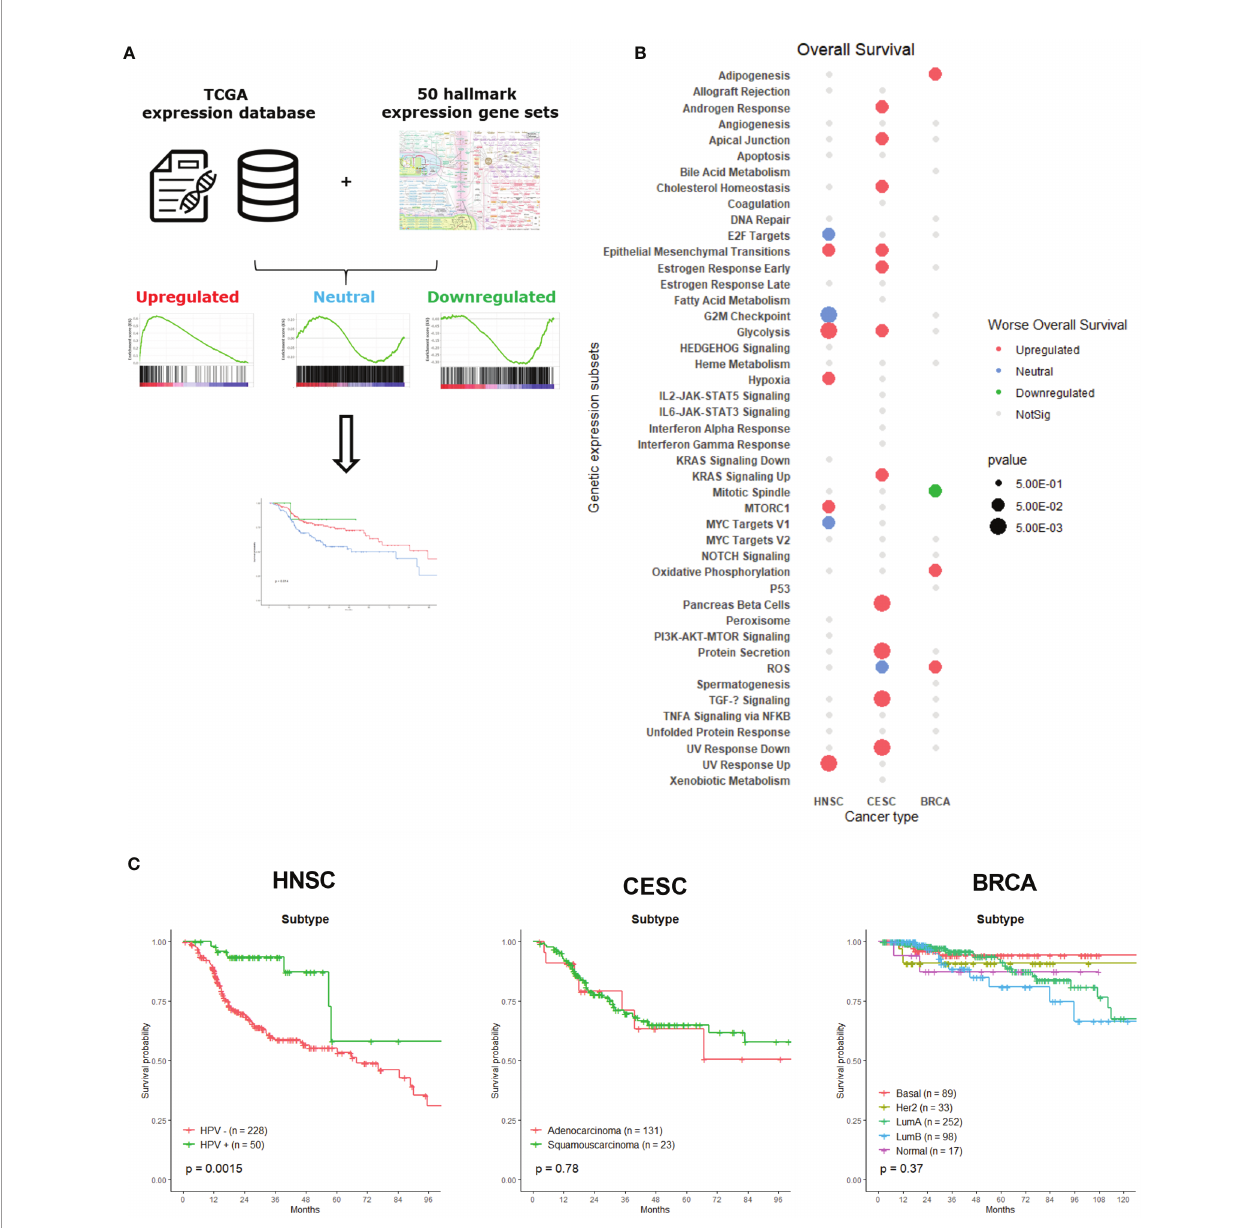
FIGURE 1 | Classi fi cation and association of gene set expression signatures with patient survival times and tumor subtypes. (A) The computational method to classify tumor samples into three expression subtypes: upregulated, neutral and downregulated. These subtypes were than associated with patient OS. (B) Clinical associations of gene set expression signatures with patient OS. Color indicates correlation direction and size the level of p-value (log-rank test). Grey dots were not signi fi cant and had p-value lower than 0.5. Blanc spots were not signi fi cant for association with OS and had a p-value higher than 0.5. (C) Kaplan-Meier plots for molecular subtypes of HNSC, CESC and BRCA associated with patient overall survival